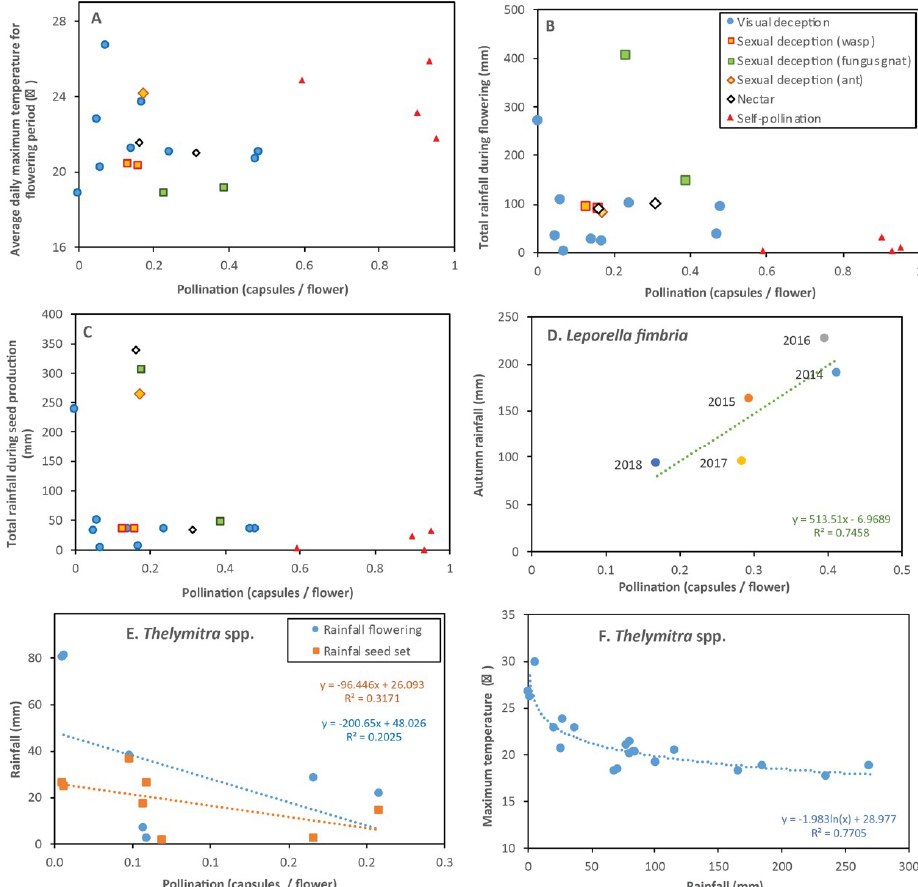
Figure 13. The influence of climate on fruit set for orchids with different pollination traits (one point for each species); ( A ) Average daily maximum temperature during flowering and seed production; ( B ) Total rainfall during flowering relative to fruit set; ( C ) Rainfall accumulation during fruit set relative to seed production; ( D ) Autumn rainfall (March to May) relative to fruit set by Leporella fimbria ; ( E ) Rainfall during flowering and fruit set for visually deceptive Thelymitra species (4 species, 3 years); ( F ) The relationship between rainfall accumulation and average daily maximum temperature during flowering for the samples in Figure 13E.Overall pollination rates were low for